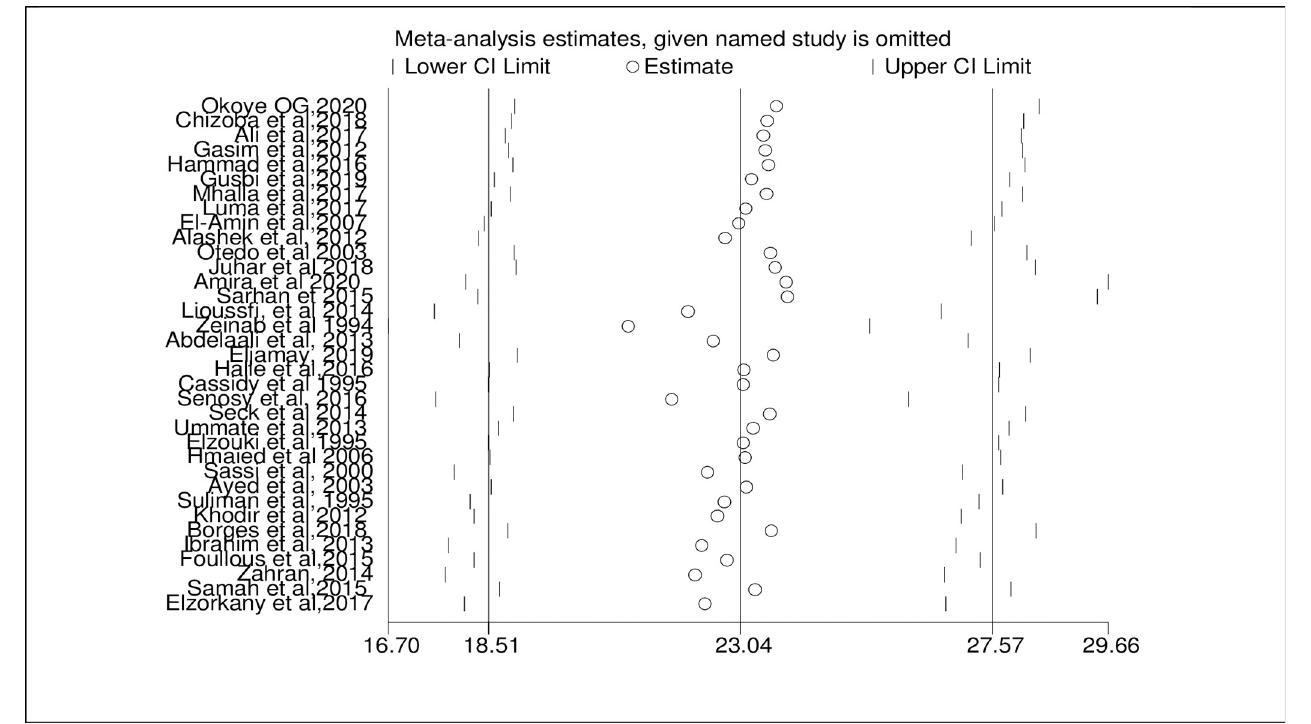
Fig 5. Sensitivity analysis of the included studies to estimate the pooled prevalence of HCV among HD